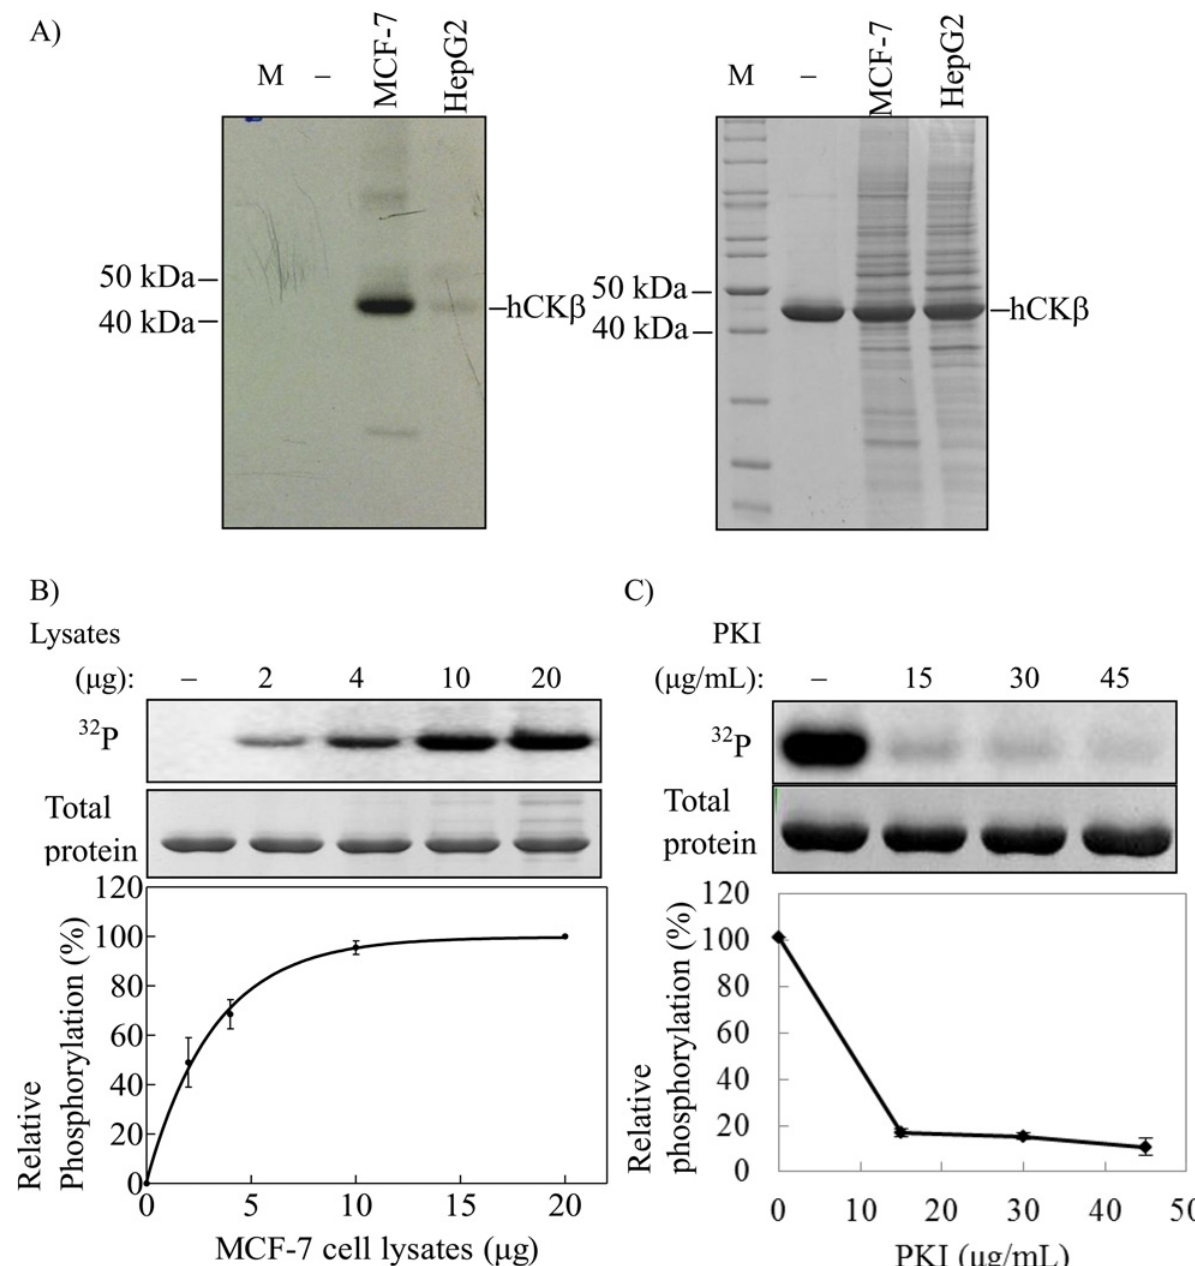
Fig 3. Phosphorylation of purified CK β by PKA in MCF-7 cell lysate. A) In vitro phosphorylation of CK β by protein kinase in 20 μ g each of MCF-7 and HepG2 cell lysates. Twenty micrograms of CK β were in vitro phosphorylated for 1 hour at 30°C as described in the experimental procedures. Five micrograms of the phosphorylated proteins were analyzed by 10% SDS-PAGE. The right panel shows Coomassie blue total protein staining of the same gel. Phosphorylated CK β was detected by autoradiography. B) The phosphorylation level of CK β is dependent on the amount of MCF-7 cell lysate. C) The phosphorylation of CK β is inhibited by PKI: Here, 20 μ g of MCF-7 cell lysate were used to phosphorylate CK β . The relative amounts of phosphate incorporated were quantified by using ImageJ 1.42. M: PageRuler ™ unstained protein